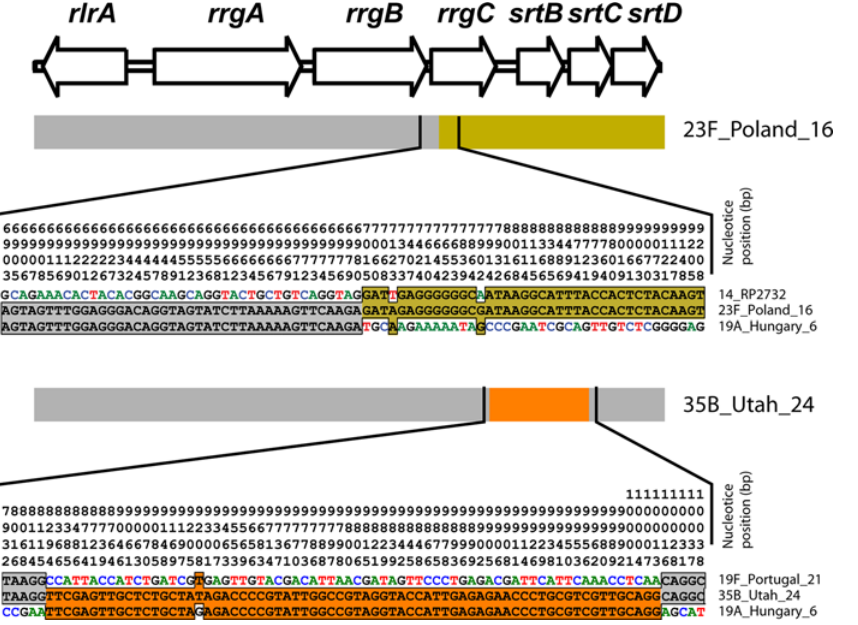
Figure 6. Detection of recent recombination events. Example of two recent recombination events that can be detected by comparing triples of sequences. Only the polymorphic sites are shown, and coordinates are reported vertically above each site. In both cases the insertion of a recombinant sequence (marked in color) in a non-recombinant background (marked in grey) is identified by a switch in the pattern of sequence conservation at the polymorphic sites.